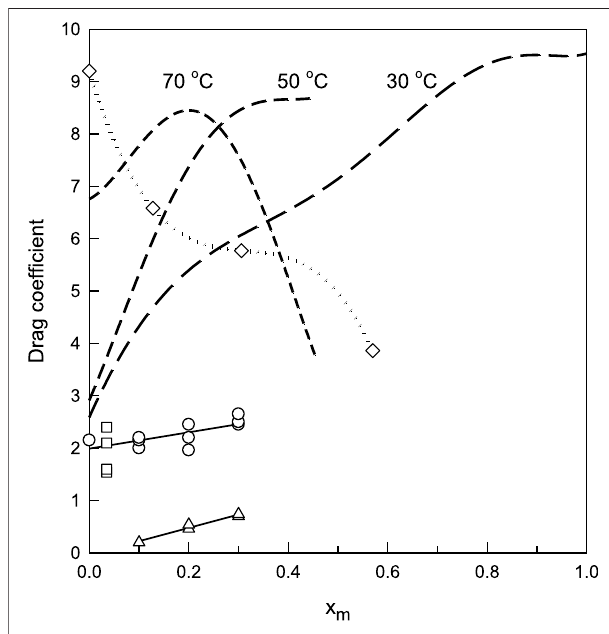
FIGURE 1 | Electro-osmotic drag coef fi cient of water – methanol mixturesinNa fi on117membranesasafunctionofcomposition.Dashedlines representthetotaldrag factorat30,50,and 70 ° Cfrom Tschinder etal.,2007; ( ○ ) at 25 ° C from Hallberg et al., 2010, ( □ ) at 30 and 60 ° C from Chi et al., 2013, ( ◇ ) at 25 ° C for the K + form from Barragan et al, 2005, and ( Δ ) methanol drag factor at 25 ° C from Hallberg et al, 2010.